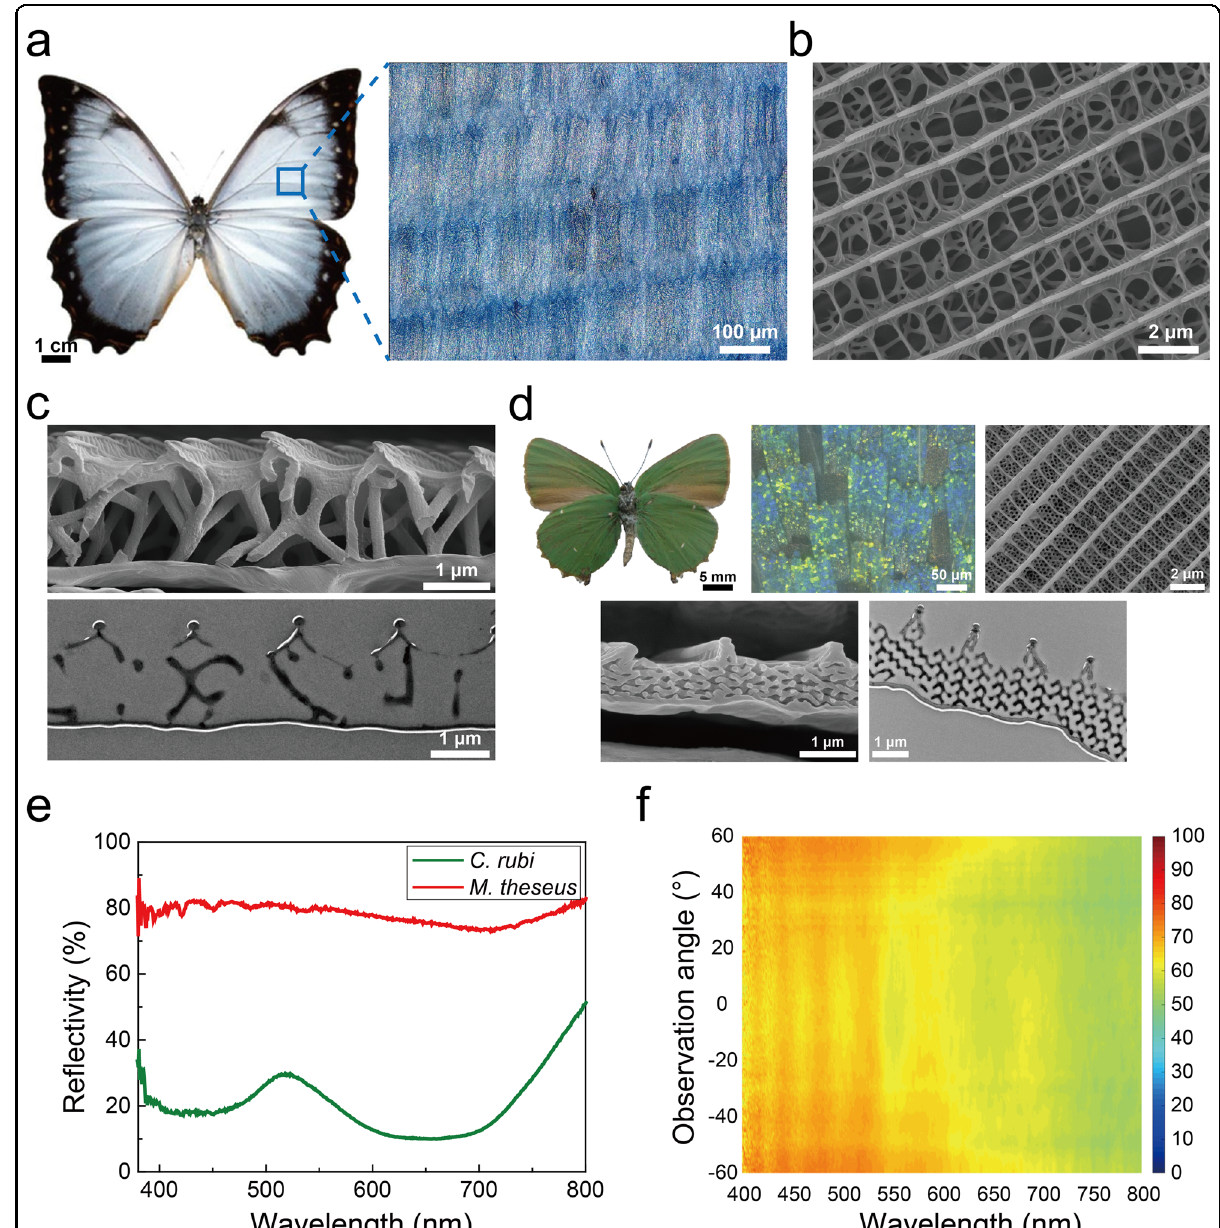
Fig. 1 Morphology and optical properties of the M. theseus wing. a Photograph and optical image of the ventral side of the M. theseus wing. b SEM image of a white scale. c SEM and TEM images of a scale cross-section. d Photograph 30 , optical, top-view SEM, cross-section SEM, and cross- section TEM images of C. rubi wing scales. e Experimental re fl ection spectra of M. theseus and C. rubi wings. f Angle-resolved re fl ection spectra of the M. theseus